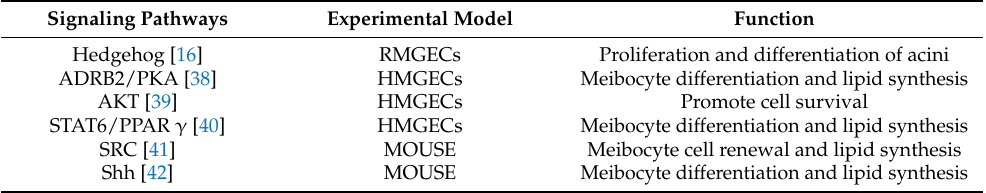
Table 1. Pathways mediating differentiation and proliferation in MGs. Signaling